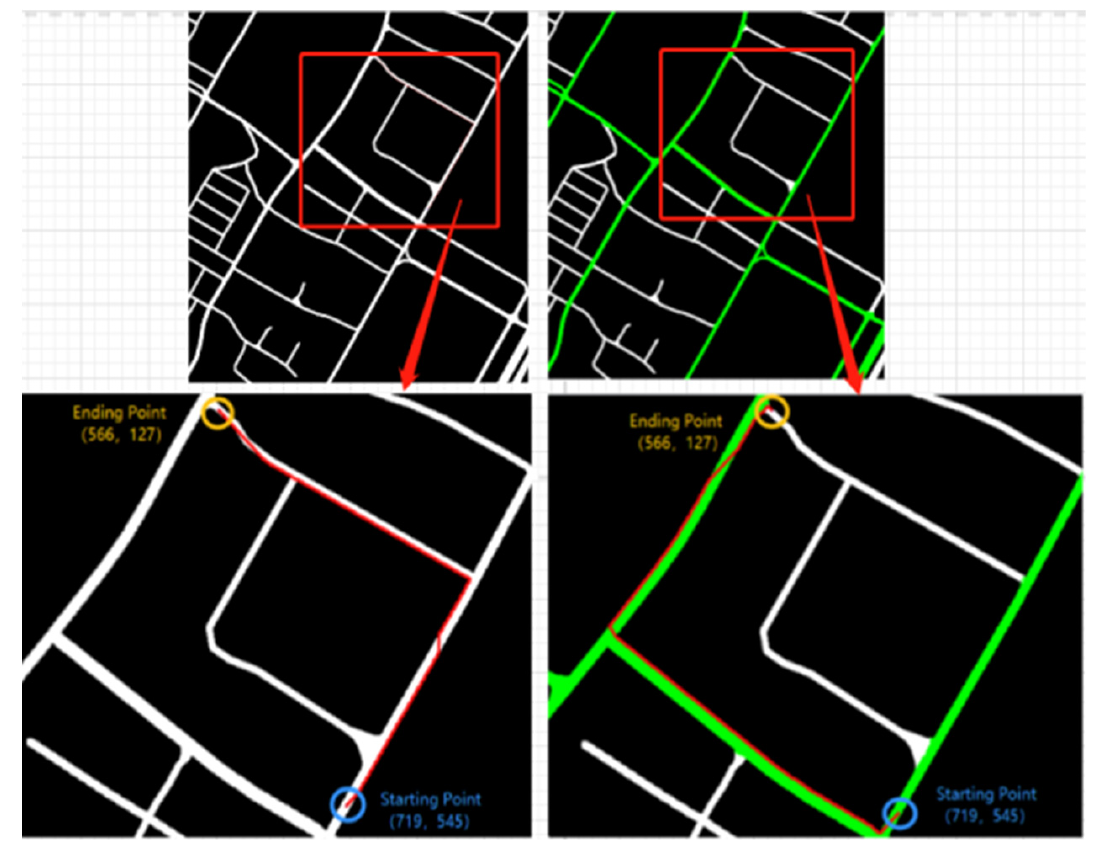
Figure 9. Optimal route planning results for the complex road maps with and without weight assignment in the previous work [48].